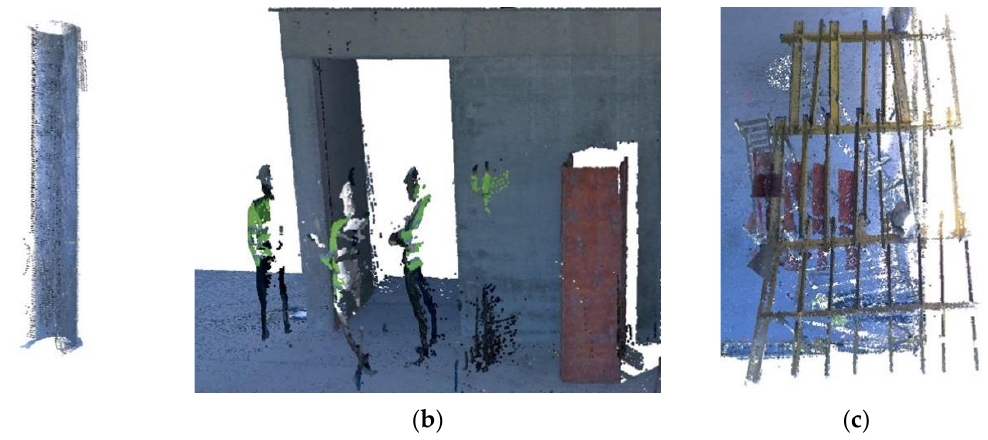
Figure 14. Data output in occluded and noisy environment: ( a ) some of the columns have shifted and duplicated, the surface of some objects is not fully scanned and is, therefore, incomplete, ( b ) an obstacle